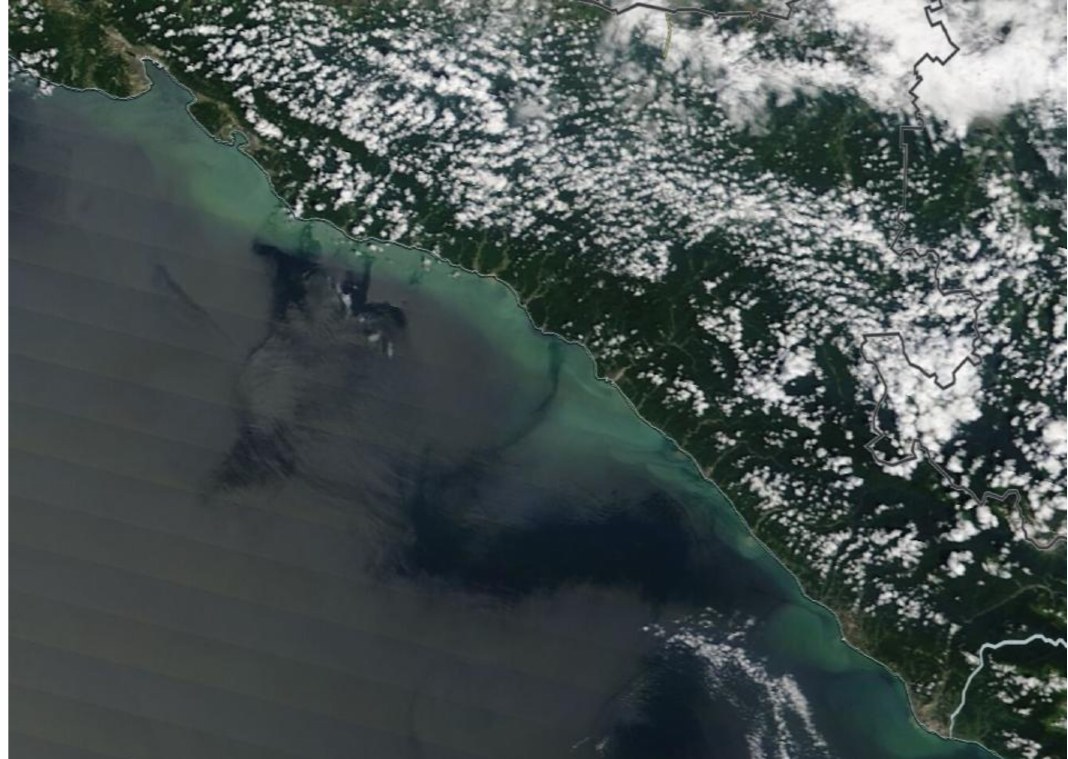
Figure 11. Joint river plumes (light green colors) along the Russian coast of the Black Sea from Novorossiysk to Adler and the border with Abkhazia on 7 July 2021 (Terra MODIS True Color Corrected Reflectance, https://wvs.earthdata.nasa.gov/ api/v1/snapshot?REQUEST=GetSnapshot&LAYERS=MODIS_Terra_CorrectedReflectance_TrueColor,Coastlines_15m, Reference_Features_15m&CRS=EPSG:4326&TIME=2021-07-07&WRAP=DAY,X,X&BBOX=43.335571,37.41211,44.84436, 40.327148&FORMAT=image/jpeg&WIDTH=1327&HEIGHT=687&AUTOSCALE=TRUE&ts=1626260065393, accessed on 14 July